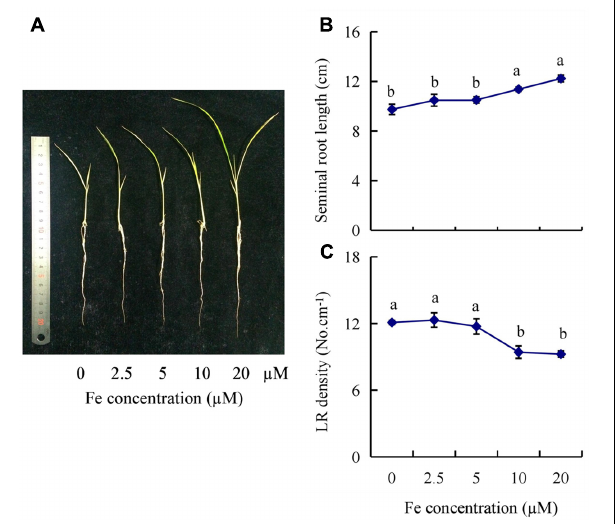
FIGURE 1 | Effects of iron (Fe) availability on root morphology in rice seedlings. Seedlings were grown in hydroponic media containing varying concentrations of Fe for 14 days. (A) The morphology of the rice plants. (B) The length of seminal root. (C) Lateral root (LR) density. Data are means ± SE and bars with different letters indicate significant difference at P < 0.05 tested with